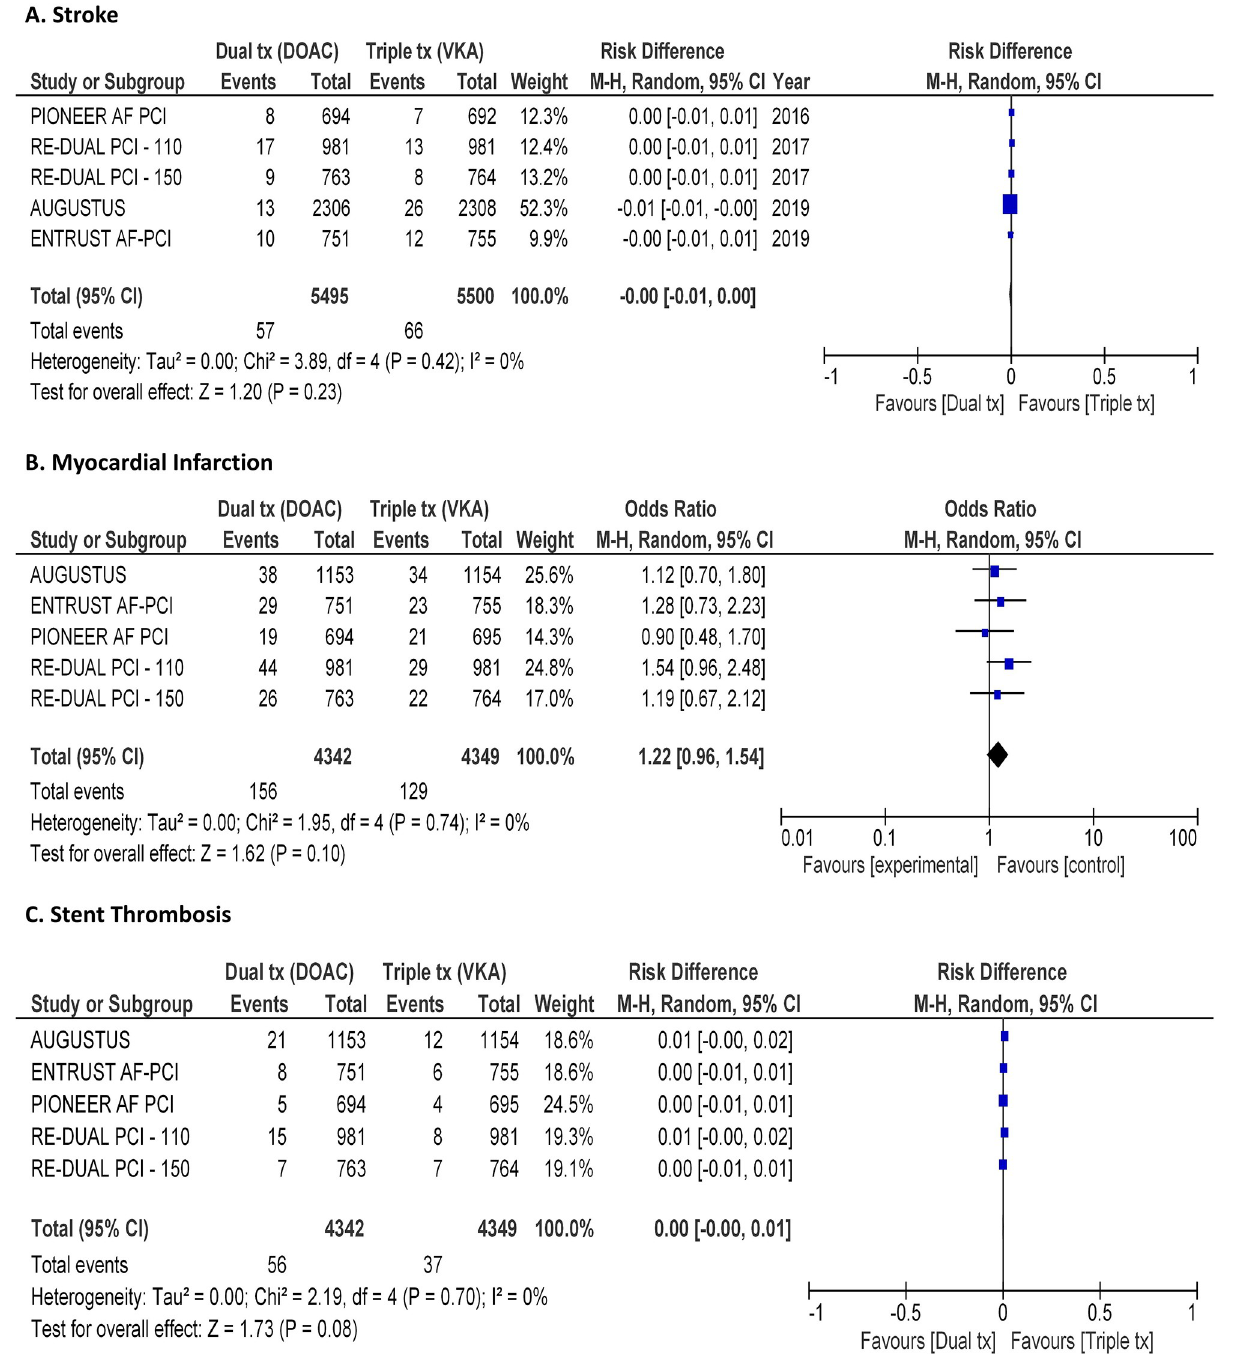
PLOS ONE | https://doi.org/10.1371/journal.pone.0235511 July 9,